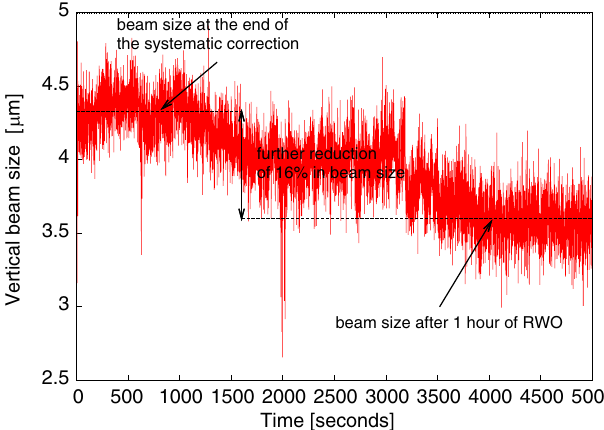
FIG. 8. Vertical beam size evolution after applying the random walk optimization at SLS